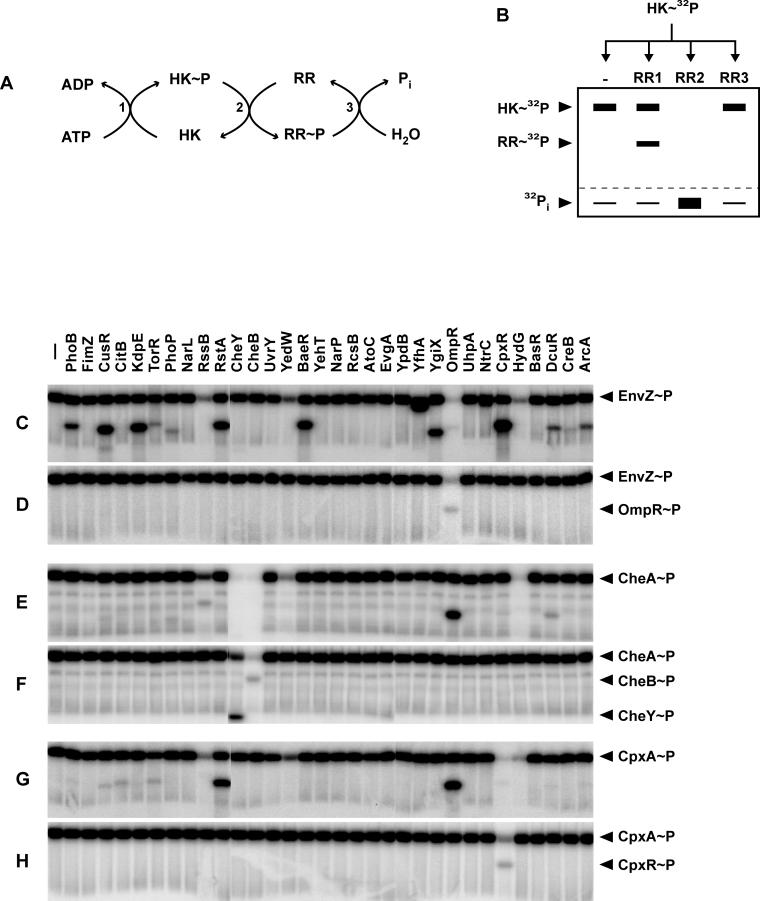
Phosphotransfer Profiling Method(A) Phosphotransfer profile experiments involve three separate reactions: (1) autophosphorylation of the histidine kinase (HK) by radiolabeled ATP, (2) phosphotransfer to a response regulator (RR), and (3) dephosphorylation of the response regulator.(B) Schematic of the phosphotransfer profiling technique. A single preparation of purified, autophosphorylated kinase (HK∼32P) is mixed with each response regulator from a given organism and analyzed for phosphotransfer by SDS-PAGE and autoradiography. The first lane shows a single band corresponding to the autophosphorylated histidine kinase and is used as a comparison for every other lane. Lanes 2–4 illustrate the three possible outcomes of a phosphotransfer reaction. In lane 2, phosphotransfer from HK to RR1 leads to the appearance of a band corresponding to RR1. In lane 3, phosphotransfer from HK to RR2 also occurs, but owing to high phosphatase activity (either autophosphatase or catalyzed by a bifunctional HK), the net result is production of inorganic phosphate (Pi) and the depletion of radiolabel from both the HK and RR2. In lane 4, no phosphotransfer occurs, and the lane is indistinguishable from lane 1.(C–H) Phosphotransfer profiling was performed for three E. coli kinases (EnvZ, CheA, and CpxA) against all 32 purified E. coli response regulators, with phosphotransfer incubation times of either 1 h (C, E, and G) or 10 s (D, F, and H). For these three histidine kinases, a comparison of the short and long time point profiles indicates a kinetic preference for only their in vivo cognate regulators: OmpR (C and D), CheY and CheB (E and F), and CpxR (G and H). After being examined for phosphotransfer, all gels are stained with Coomassie to verify equal loading of histidine kinase and response regulator in each lane (data not shown). For each kinase profiled, we purified only its soluble, cytoplasmic domain, either as a thioredoxin-His6 or a His6-MBP fusion, using standard metal affinity chromatography (see Materials and Methods). When necessary, we made successive N-terminal truncations until we identified a construct that produced active kinase in vitro, always preserving the H-box and ATP binding domain (details on constructs used are in Table S3). All response regulators were purified as full-length fusions to a thioredoxin-His6 tag. Purity was assessed by Coomassie staining, with each purified kinase domain and response regulator, except for E. coli FimZ, yielding an intense band of the correct approximate molecular weight (see Figure S5; Table S3).